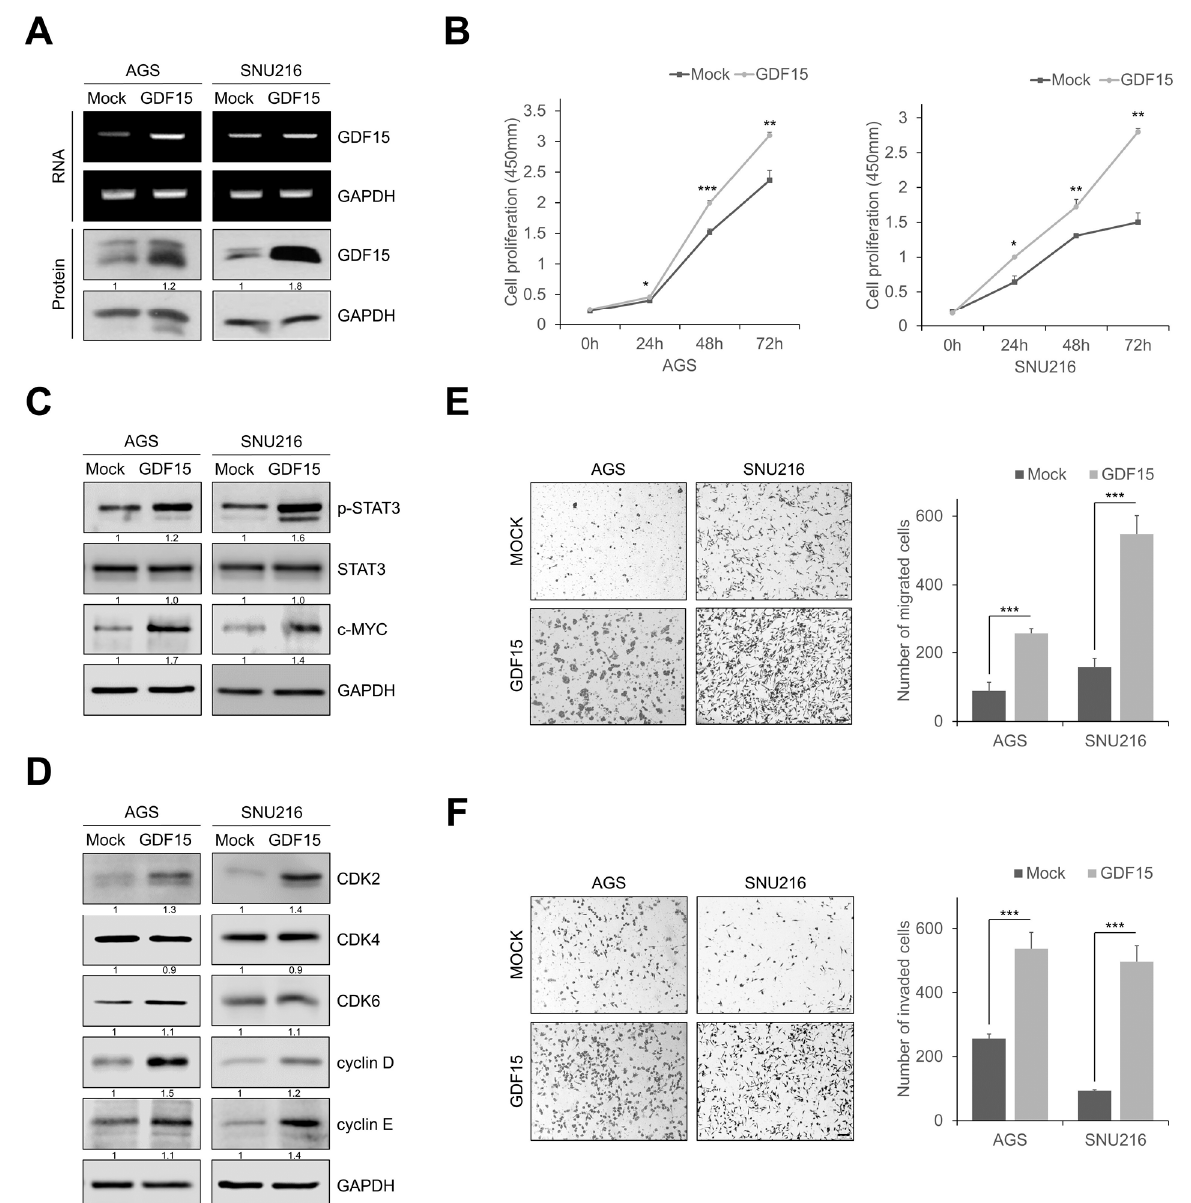
Figure 5. GDF15 overexpression promotes cell proliferation, migration, and invasion by upregulating STAT3 signaling. ( A ) Western blotting analysis and RT-qPCR for GDF15 in GDF15-overexpressing cells. ( B ) In GDF15-overexpressing cells, the cell proliferation rate by the cell counting assay and absorbance was measured at 450 nm using a spectrophotometer. Data are presented as the mean ± SD and were evaluated using Student’s t -test ( n = 3). ( C ) Western blot analysis showing an increased expression of phosphorylated STAT3 and c-MYC in GDF15-overexpressing cells. ( D ) Western blotting analysis showing the expression of cell-cycle-related proteins. ( E , F ) Transwell migration and invasion assays of GDF15-overexpressing cells. Cells were counted in five randomly selected fields. Data are presented as the mean ± SD and were evaluated using Student’s t -test ( n = 3). Scale bars, 100 μ m. * p < 0.05, ** p < 0.01, and *** p < 0.001.